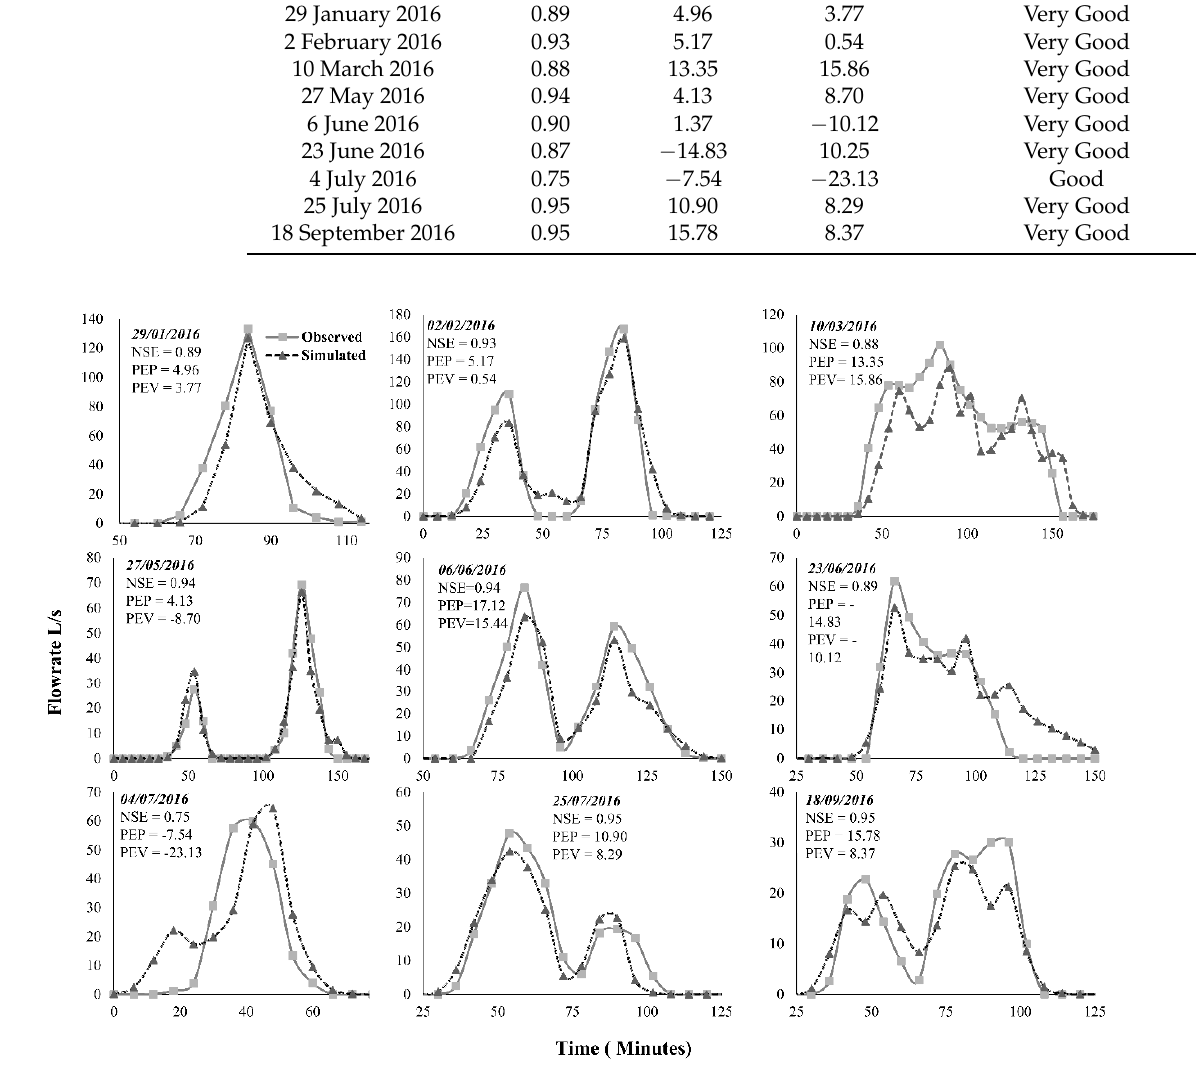
Figure 6. A comparison of the observed and simulated hydrographs of individual storms extracted from the continuous simulation runoff time series from the MUSIC model. Goodness-of-fit statistics are also presented with event data.